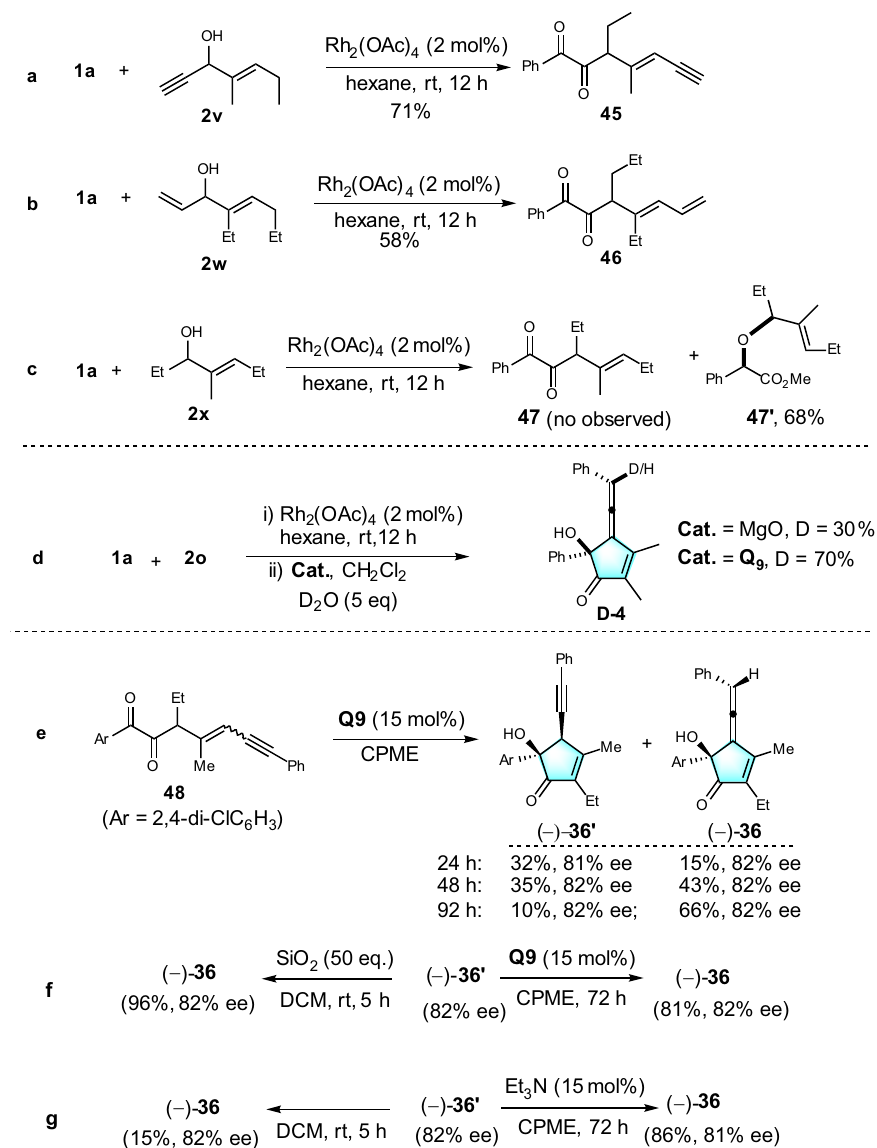
Fig. 6 Control experiments and mechanism studies. a 1,4-enyne allylic alcohol as substrate. b 1,4-dienyl allylic alcohol as substrate. c monoallylic alcohol as substrate. d Deuterium experiment. e The coversation of compound 48 in different time periods. f Both Q9 and SiO2 accelerate ( – ) – 36 ‘ conversion to allene ( – ) – 36. g ( – ) – 36 ‘ in the condition of base or CH 2 Cl 2